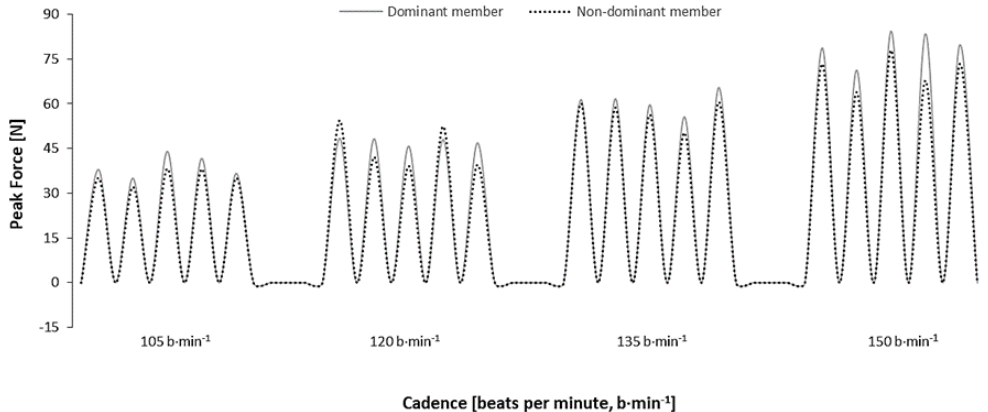
Figure 2. Example of the peak propulsive force between the dominant (solid line) and nondominant limbs (dashed line) during horizontal adduction (HA) in incremental protocol.